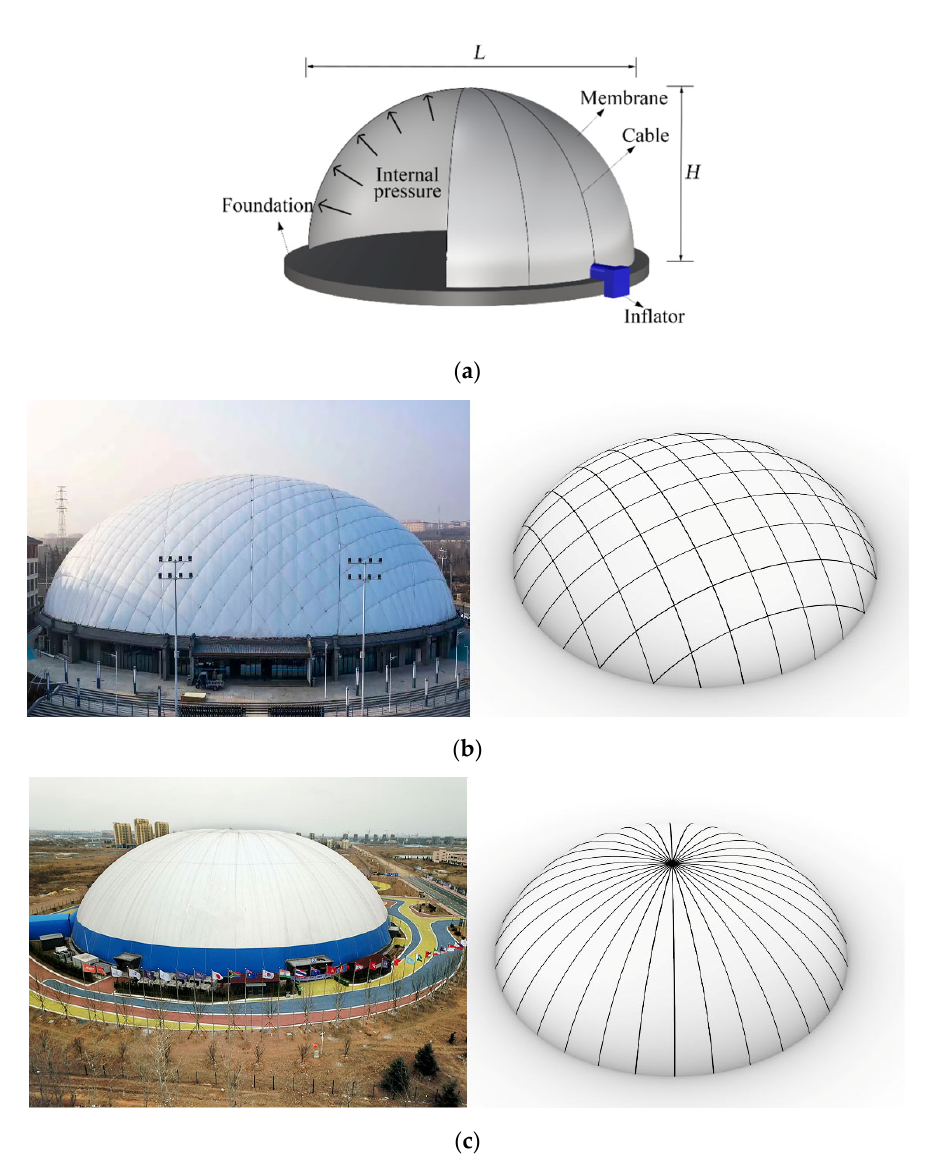
Figure 1. Schematic diagrams and practical photos of spherical inflatable membrane structures: ( a ) A schematic diagram of structural shape and composition; ( b ) Spherical inflatable membrane structure with cross cables; ( c ) Spherical inflatable membrane structure with radial cables.